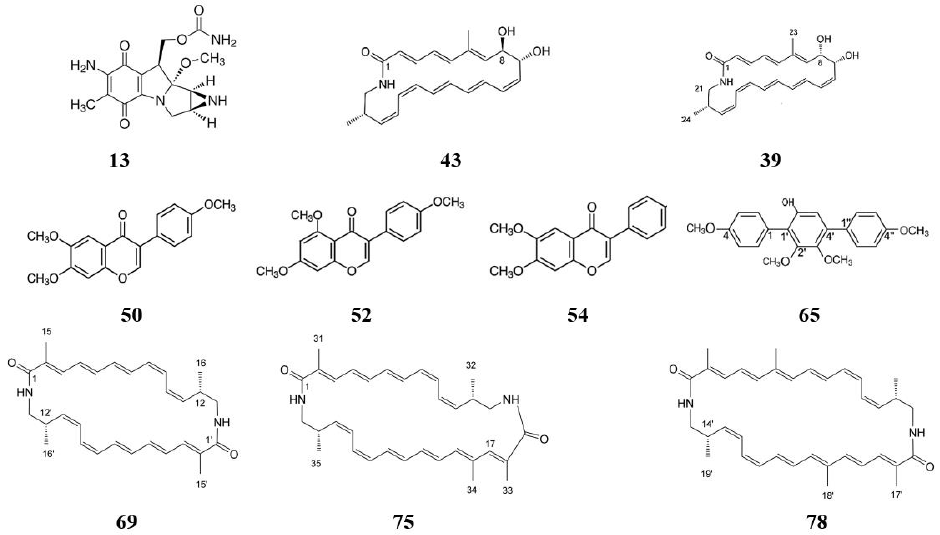
Figure 3. Structures of compounds identified from crude extract prepared from the culture of strain CG3 in